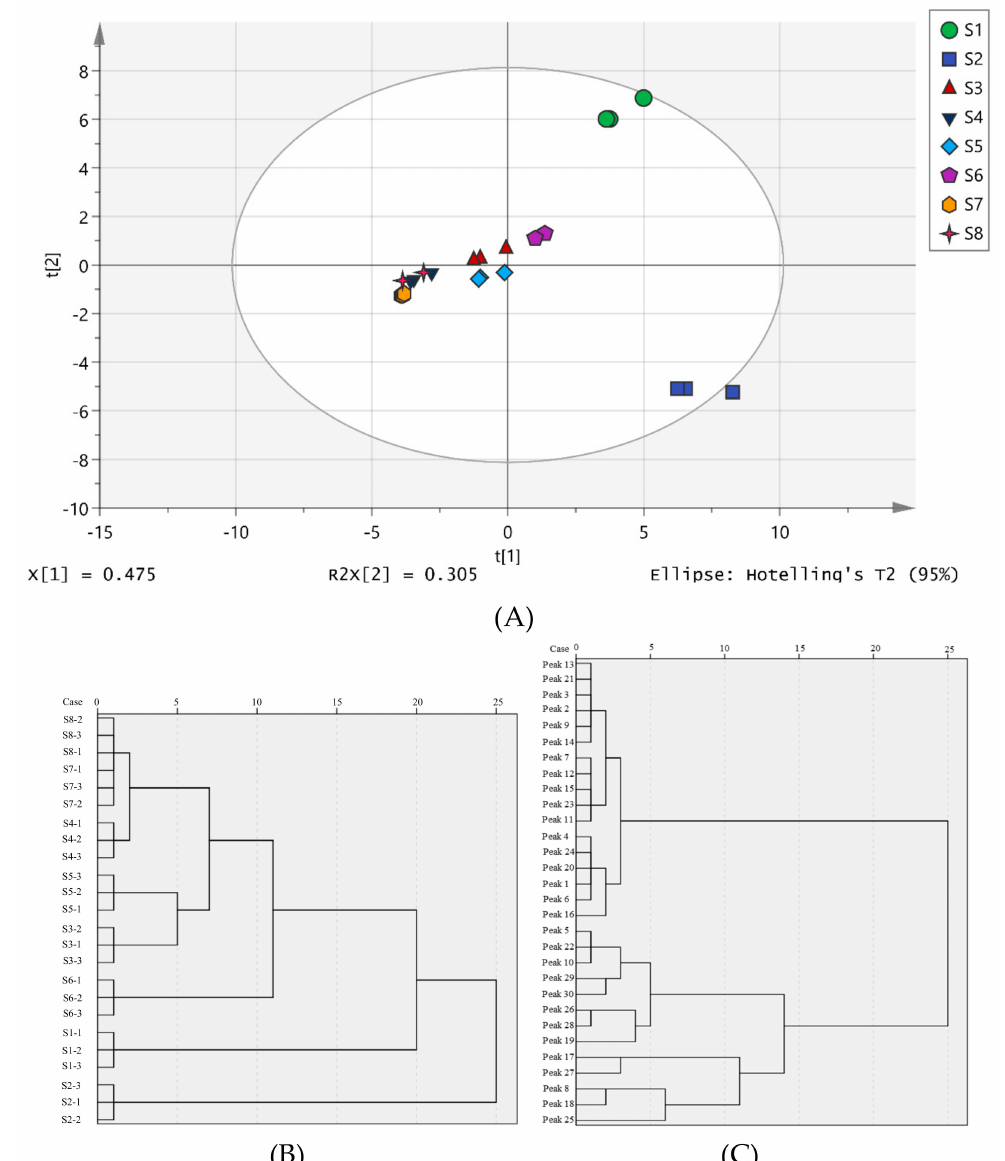
Figure 3. Multivariate statistical analysis of fresh sample and seven processed samples. ( A and B ) The PCA score plot and HCA plot of the LC-MS data set; ( C ) HCA plot of the LC-MS data based on chemical constituents. The compounds were identified either by MS2 spectra* or by